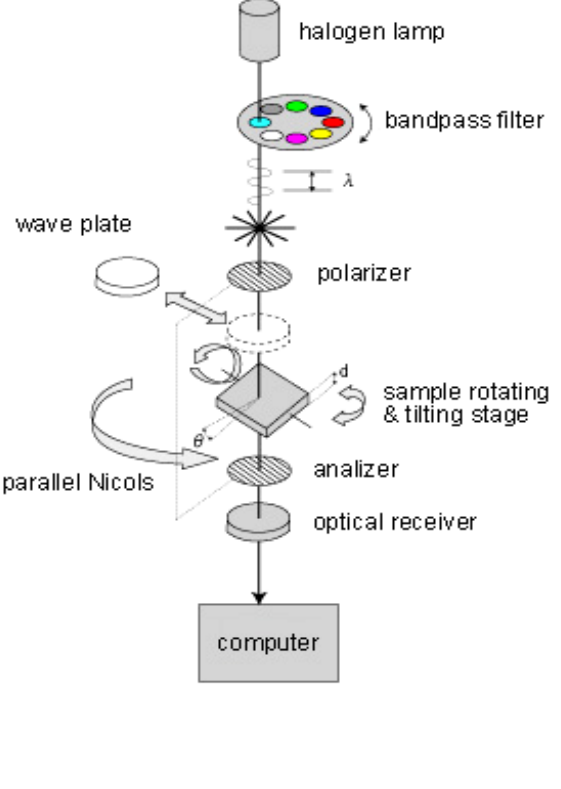
Figure 5. Birefringence measurements by parallel Nicols